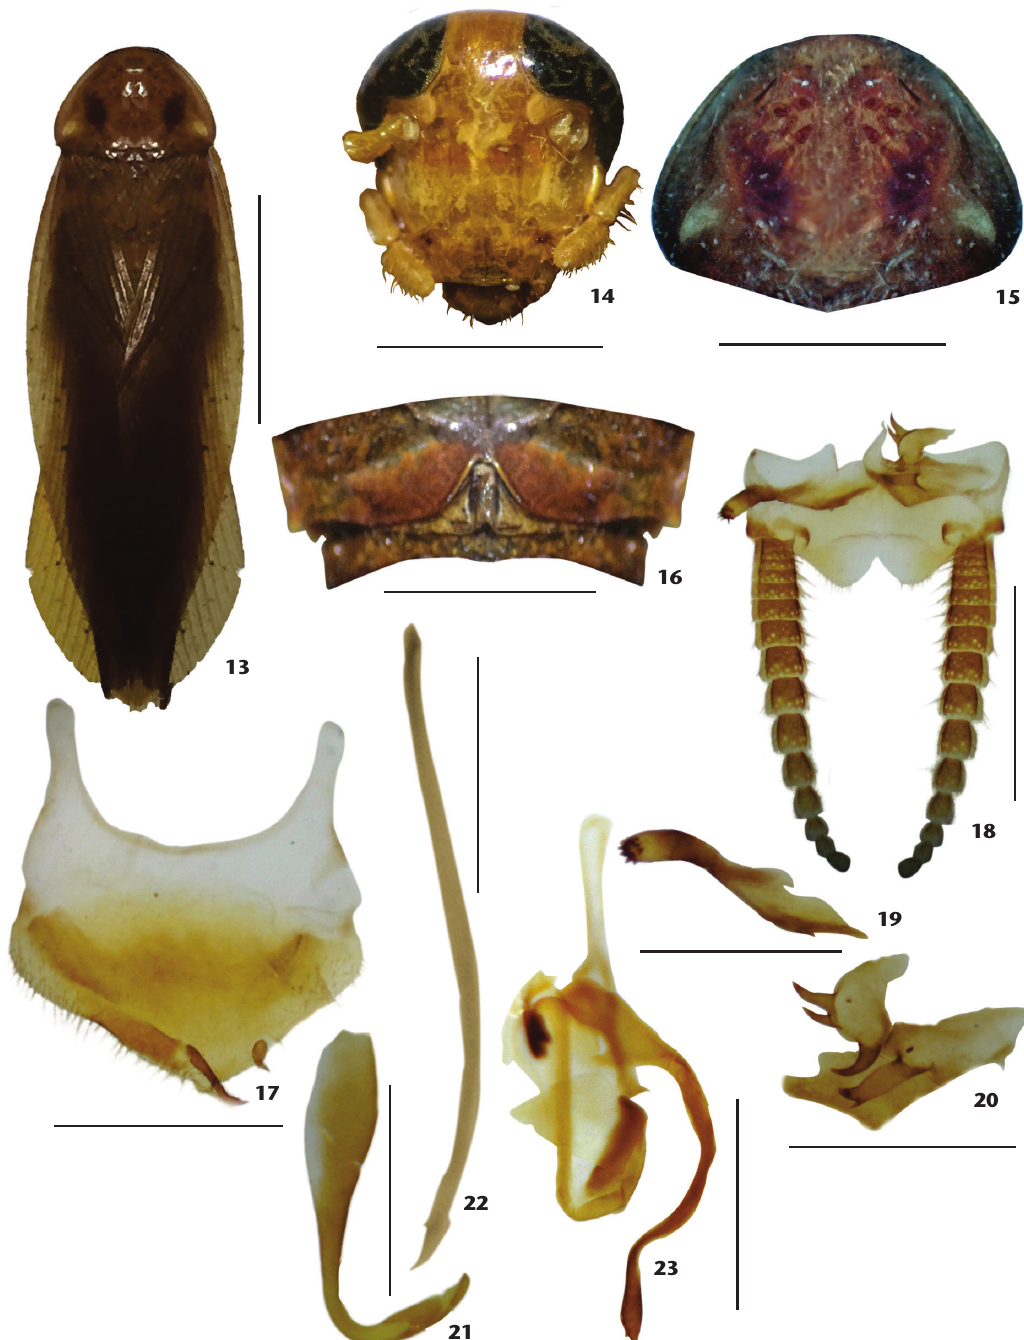
9Figures 13-23. Xestoblatta amaparica , paratype male: (13) Habitus, dorsal view, length 23 mm; (14) head, ventral view; (15) Pronotum, dorsal view; (16) Tergal modification of the tergite VII, dorsal view; (17) Subgenital plate, ventral view; (18) Supra anal plate, dorsal view; (19) Left paraproct, dorsal view; (20) Right paraproct, dorsal view; (21) Left phallomere (L3), dorsal view; (22) median sclerite (L2vm), dorsal view; (23) Right phallomere (R2), dorsal view. Scale bars: 14, 16 = 2.5 mm, 15 = 3.0 mm, 17-18 = 2.0 mm, 19-20, 22-23 = 1.0 mm, 21 = 0.7 ZOOLOGIA 33(6): e20160041 | DOI: 10.1590/S1984-4689zool-20160041 | December 15, 20164 /